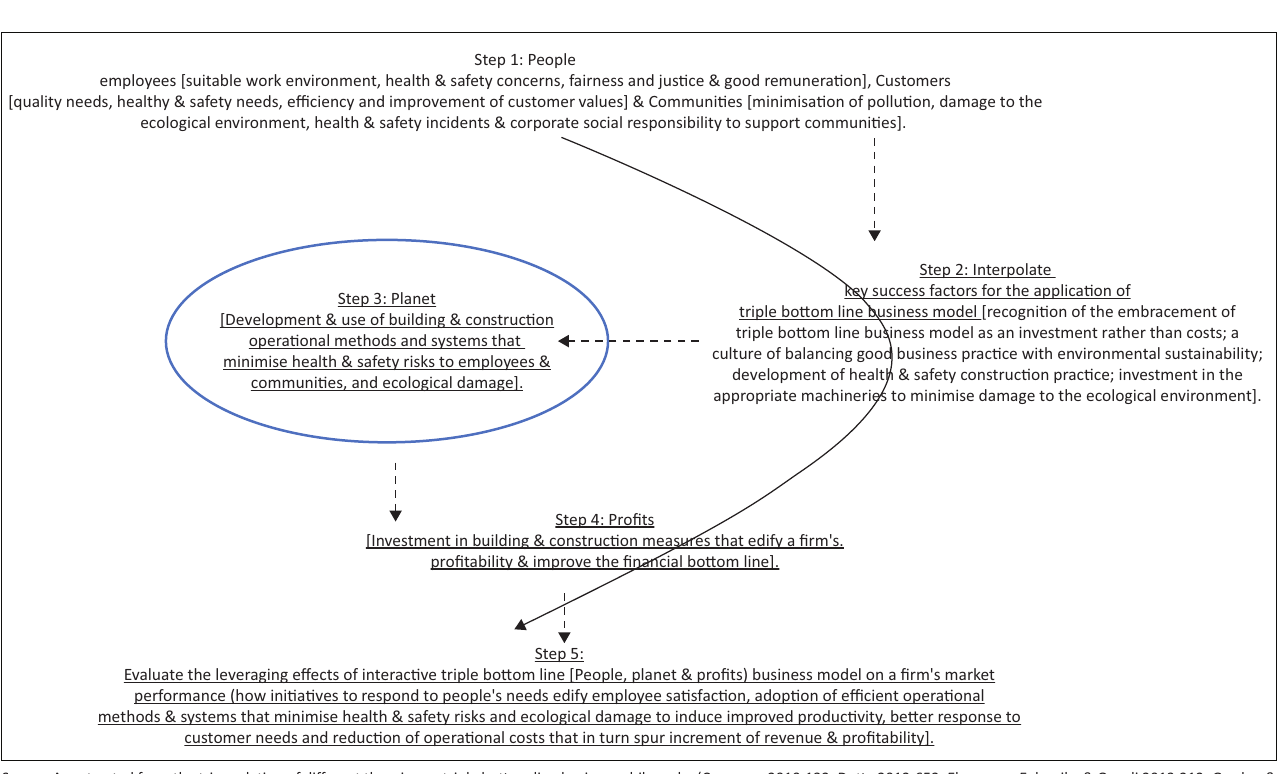
FIGURE 2: A remedial business model for leveraging the effects of the triple bottom line business model on the building and construction small and medium-sized enterprises’ market